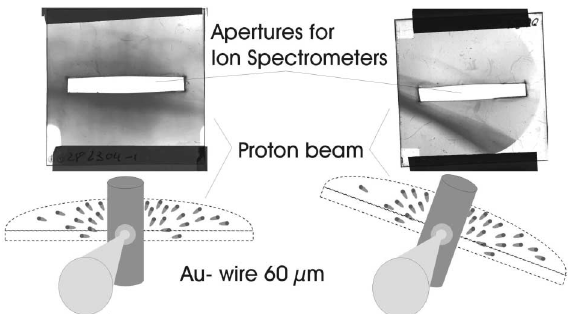
FIG. 4. Experimental setup and RCF images of experiments with 60 m m gold wires. The convex rear surface constitutes a decollimating cylinder lens. Accordingly, the proton beam was formed into a